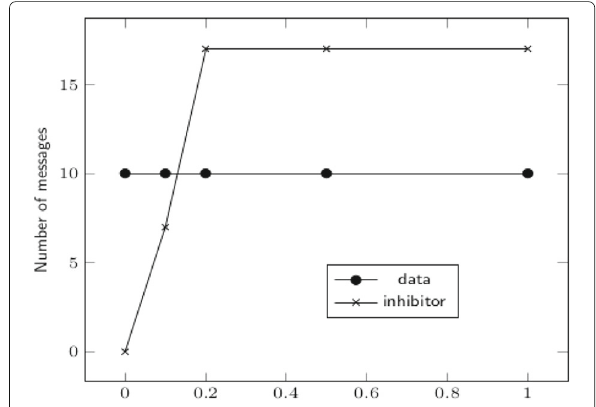
Fig. 18 Total number of data and inhibitor messages in the network with time